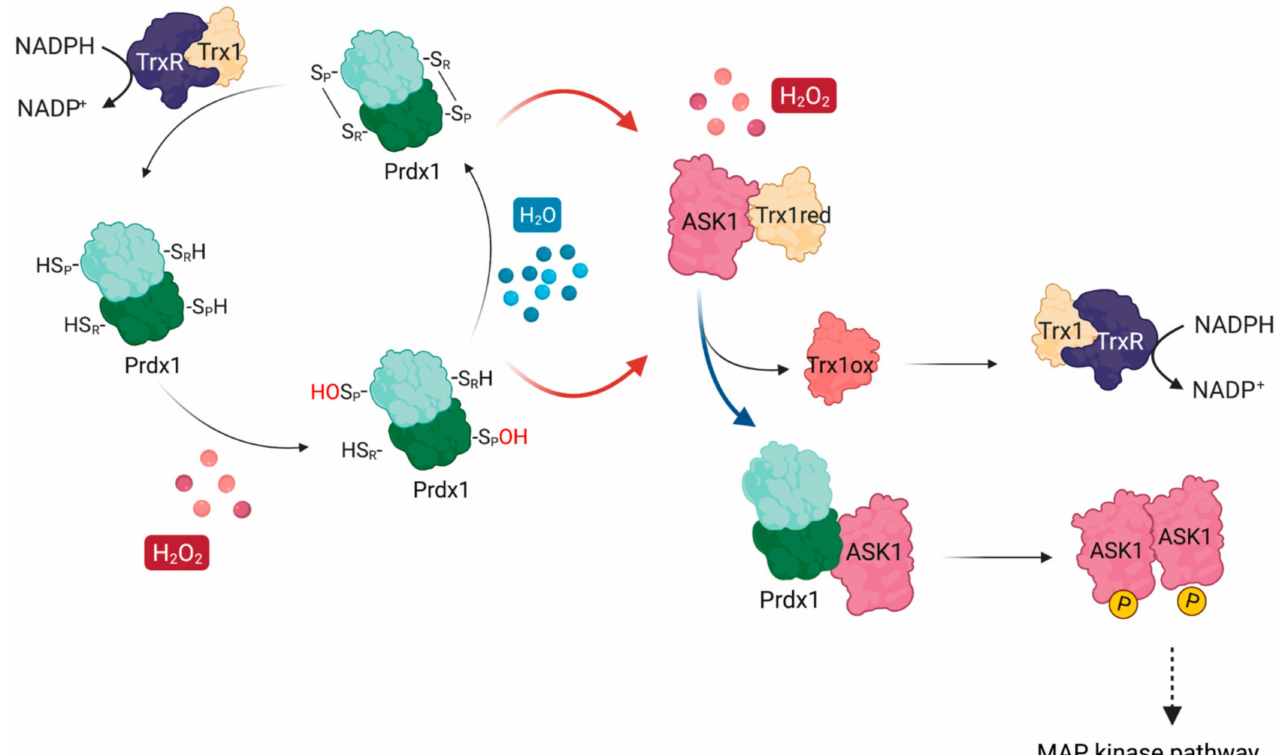
Figure 1. ASK1 is redox-regulated by Prdx1 in the presence of H 2 O 2 . At basal H 2 O 2 levels, reduced Trx1 binds ASK1 non-covalently at its TBD, shielding reactive cysteines (e.g., Cys250). At increasing H 2 O 2 levels, H 2 O 2 oxidizes Prdx1 and leads to the release of oxidized Trx1 from ASK1, exposing the reactive cysteines. Oxidized Prdx1 then transfers oxidative equivalents to ASK1 (red arrows), wherein ASK1 performs a nucleophilic attack either on the intramolecular disulfide bond of Prdx2, or on the sulfenylated Cys P , leading to the formation of ASK1 disulfide-linked multimers, which are required for its kinase activity. Activated ASK1 becomes autophosphorylated, and in turn phosphorylates MAPKK, activating the p38/JNK signaling pathway, which leads to the expression of regulatory genes related with apoptosis, cell cycle regulation, and inflammation. Oxidized Trx1 is reduced via